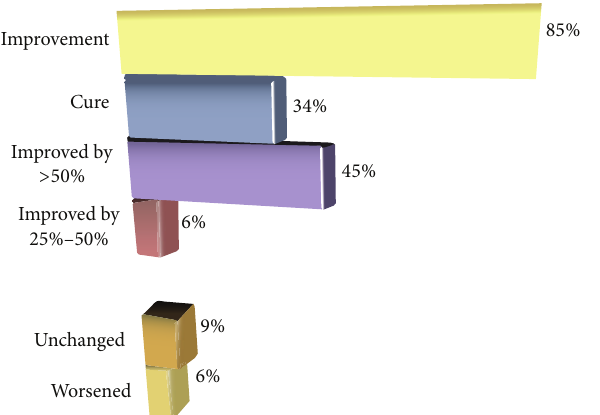
Figure 4: Migraine status in 150 consecutive patients with Amplat- zer PFO closure at an average of 5 ± 2 years of follow-up. The average age of the patients was 51 ± 11 years, 61% were males, and 91% had complete closure by 6-month transesophageal echocardiography. Antiplatelet treatment had been stopped at the latest 6 months after the